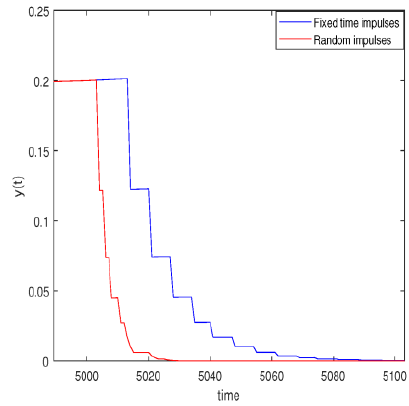
Figure 4. Comparative results between fixed and random time impulsive effects of system ( 24 )